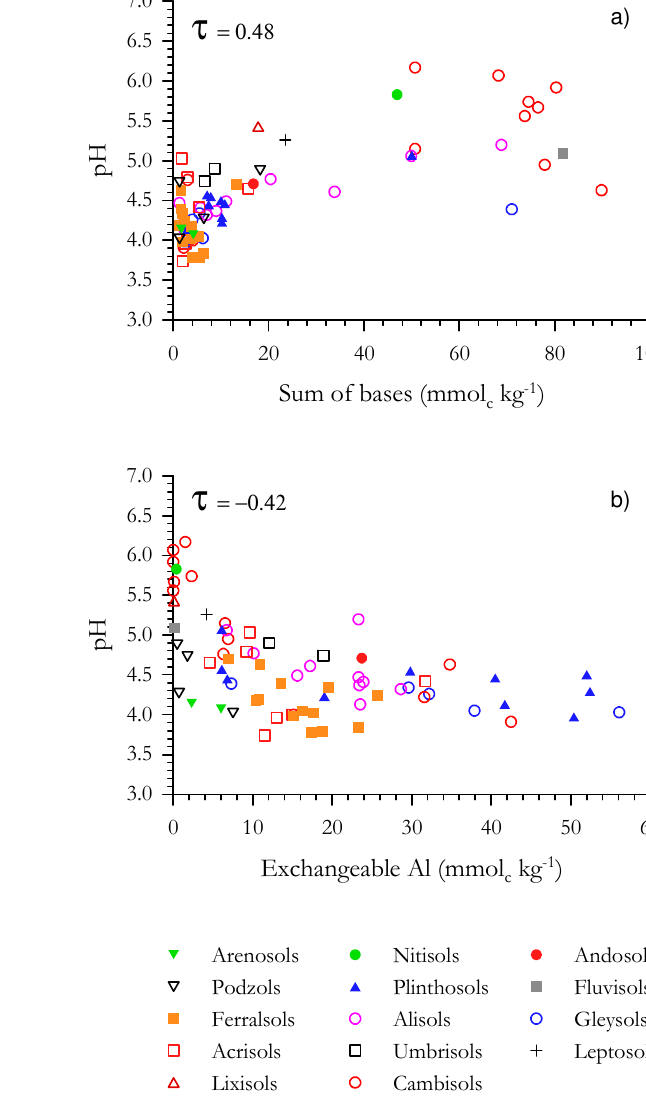
Fig. 5. (a) and (b) : Relationship between soil pH and sum of bases (top) and exchangeable aluminium (below). Values of Kendall’s τ rank correlation coefficient are also shown for which values > 0.19 can be taken as significant at